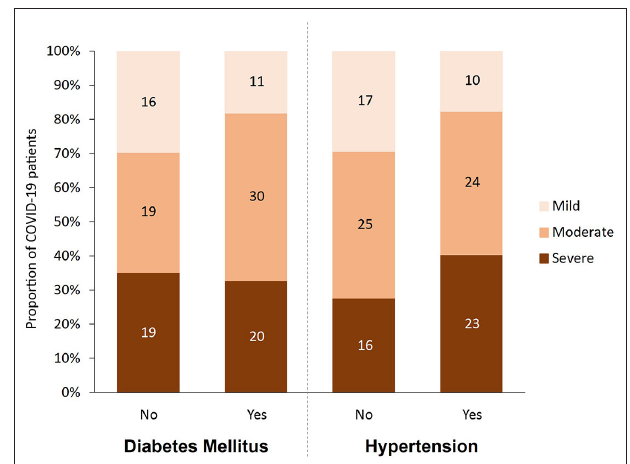
FIGURE 1 | Participants categorized by disease severity (mild, moderate and severe), diabetes status (yes, no), and hypertension status (yes, no).